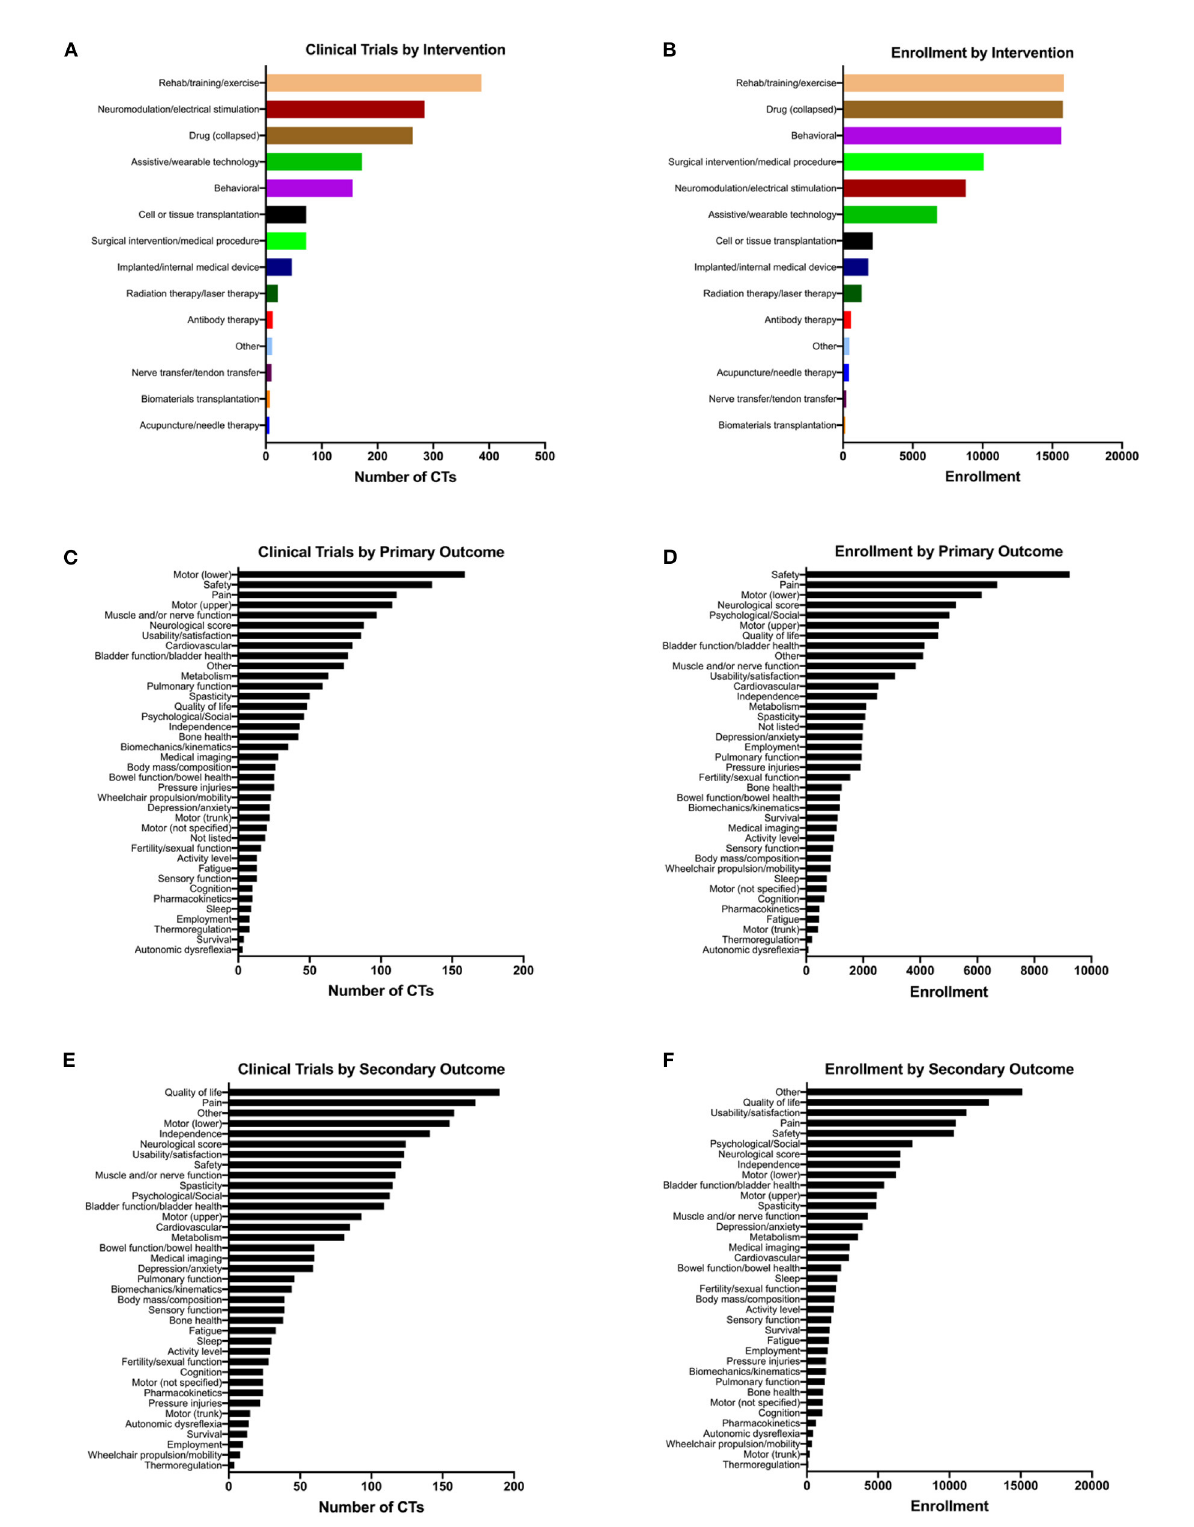
FIGURE3 Therapeutic spinal cord injury clinical trials classified according to intervention and outcome types. Note that a given trial may have more than one intervention and multiple outcomes, so the total numbers of clinical trials in (A,C,E) add up to more than 1,149. (A) The total number of clinical trials for each class of intervention. (B) The cumulative enrollment for all clinical trials that use each type of intervention. (C,E) The total number of clinical trials listing each type of (C) primary and (E) secondary outcome. (D,F) The cumulative enrollment for all clinical trials that list each type of (D) primary and (F) secondary